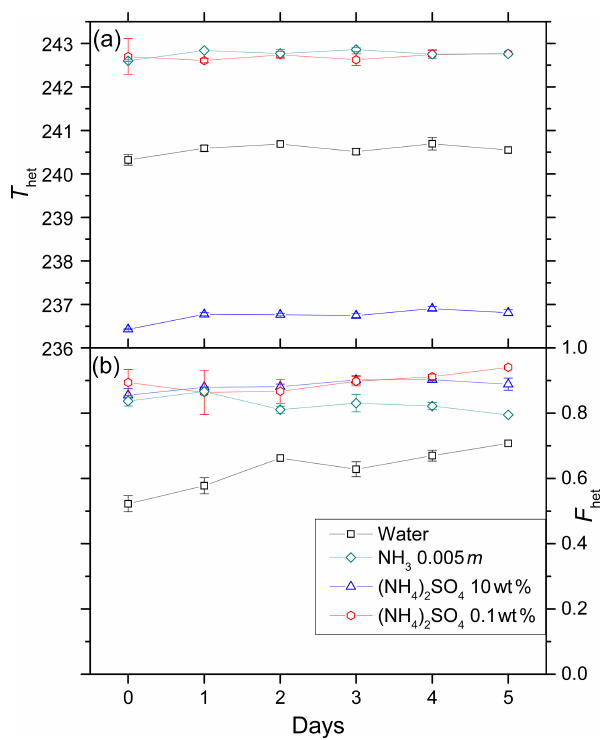
Figure 6. Development of T het (a) and F het (b) for 5wt% kaolin- ite suspended in water, 10wt% ( NH 4 ) 2 SO 4 , 0.1wt% ( NH 4 ) 2 SO 4 , 0.005molal ammonia solutions over a period of 5 days. Data points depict mean (with error bars representing min to max) for T het and F het measured for two aging experiments performed with two inde- pendently aged